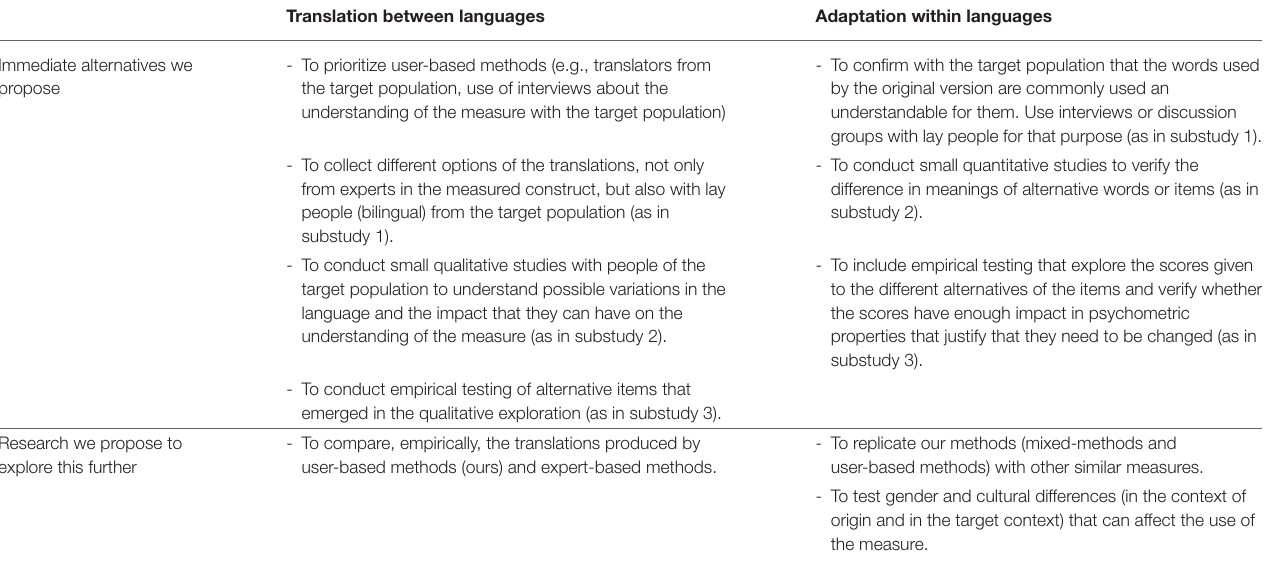
TABLE 5 | Recommendations for translation and adaptations of outcome measures used in psychotherapy